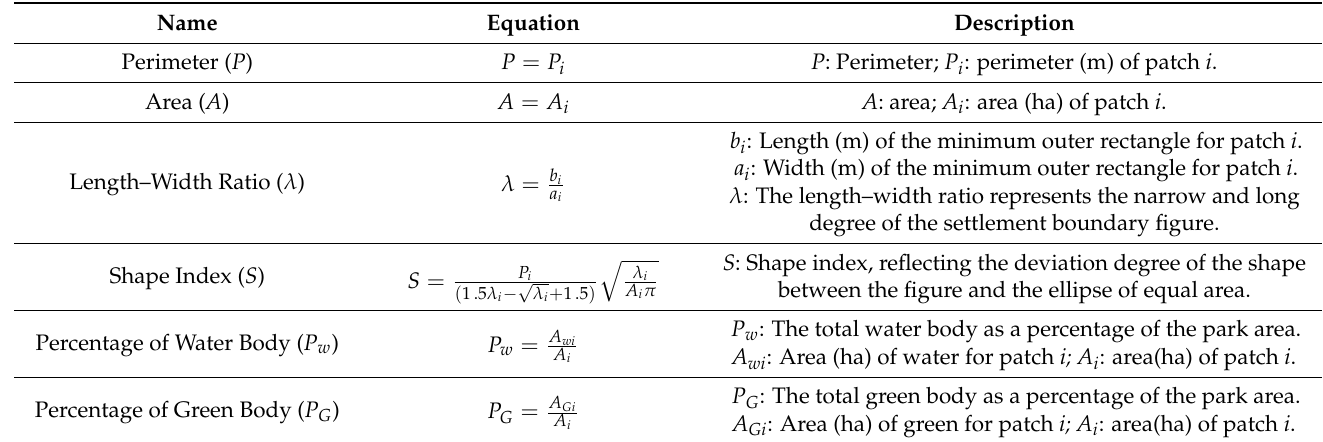
Table 1. Urban park patch indicators used in this study.